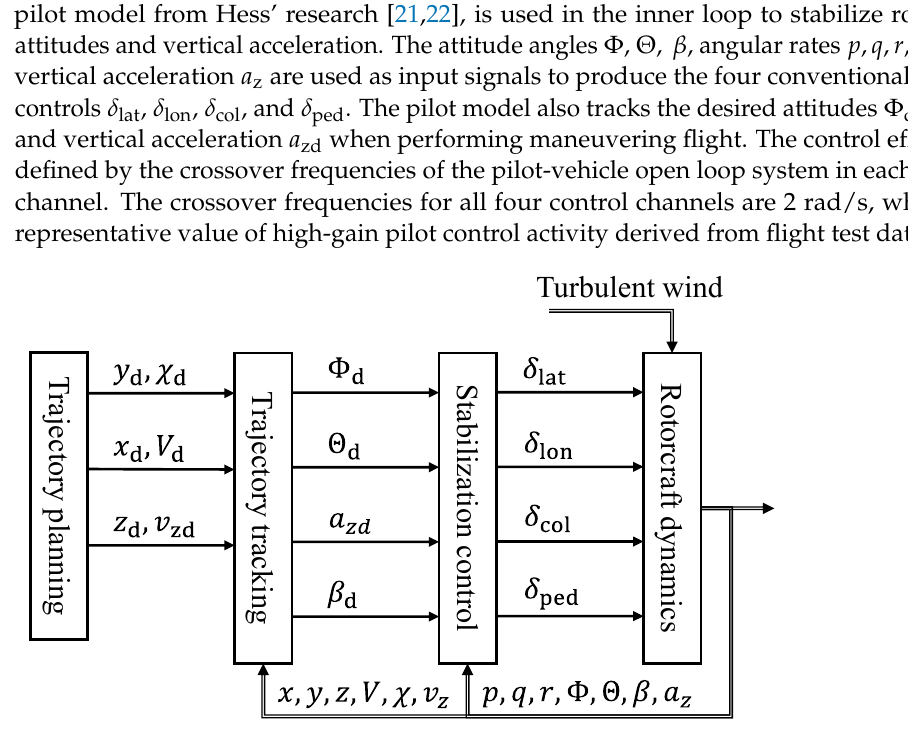
Figure 10. Control strategy for rotorcraft maneuver in turbulent wind.